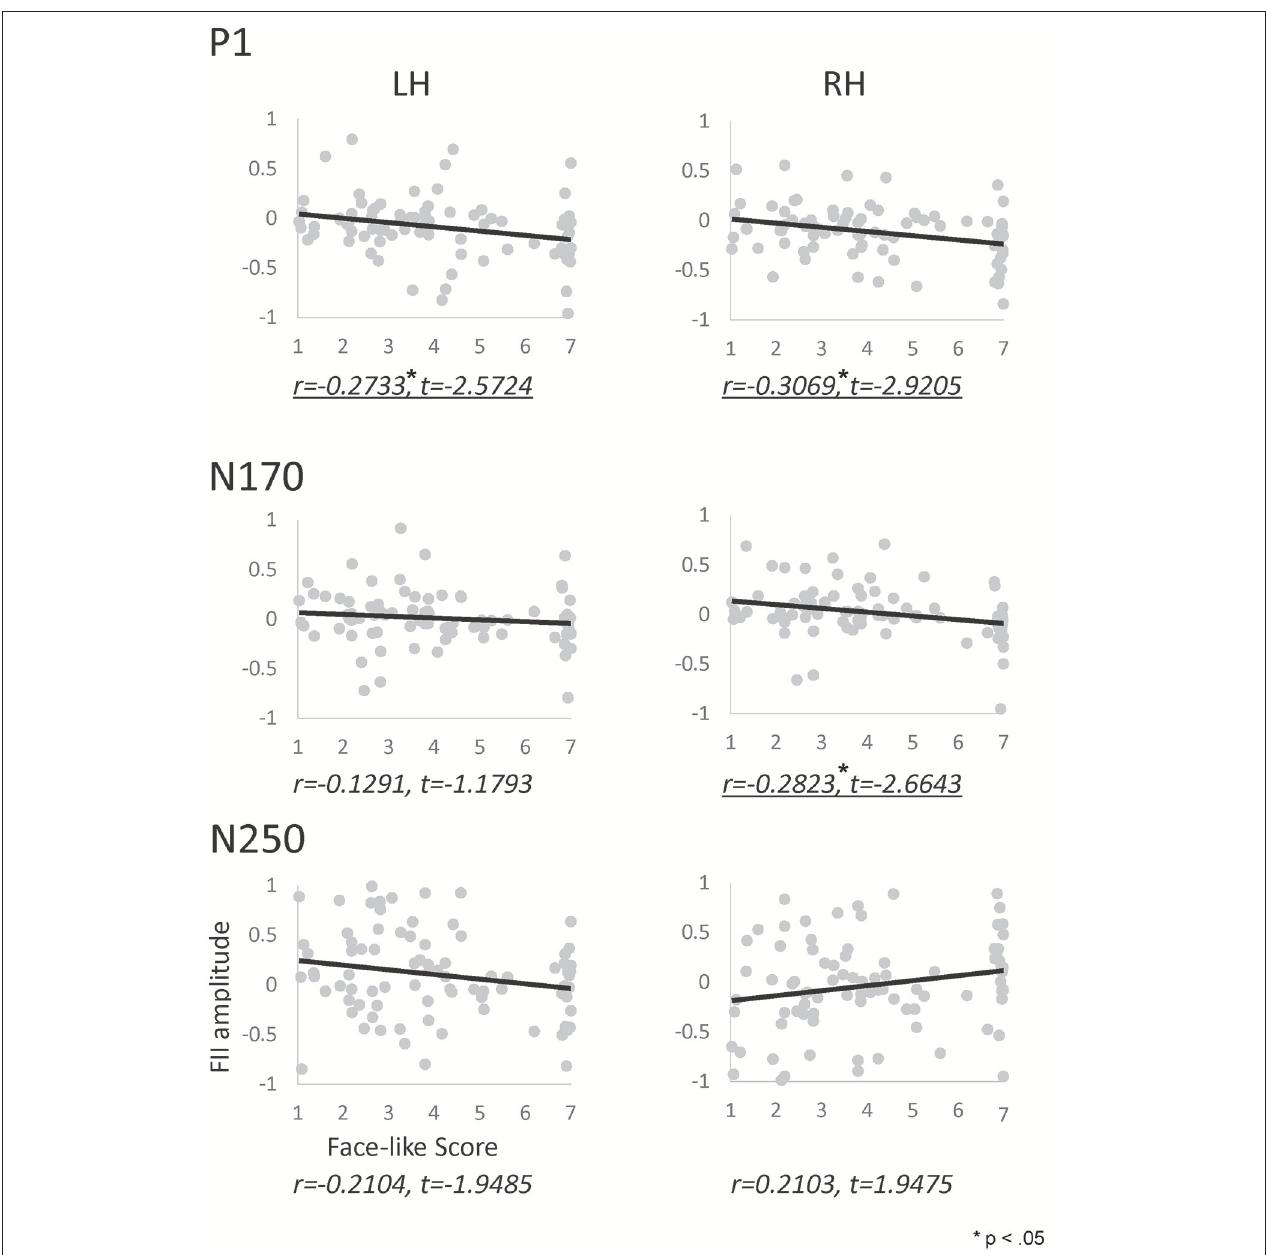
FIGURE 6 | Correlation map between the inversion effect index and the face-likeness score of P1 (Top) , N170 (Middle) , and N250 (Bottom) components, calculated for the left (left side) and right (right side) hemispheres. The vertical axis indicates the inversion effect index value, and the horizontal axis indicates the face-likeness scores. Underlines indicate significant